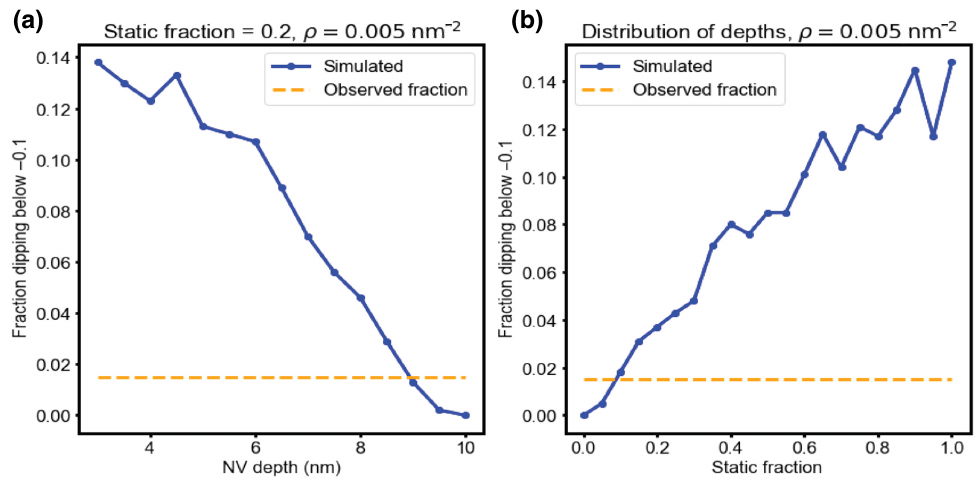
FIG. 22. Stationary surface spin fraction. (a) Simulation of the fraction of NV centers that exhibit strong coupling in DEER as a function of depth, if 20% of spins on the surface are placed randomly relative to the NV center and then do not hop. (b) Simulation of the fraction of NV centers that exhibit strong coupling in their DEER signal as a function of the fraction of spins that are stationary on the surface, given a density of σ = 0.005 nm − 2 , and depths drawn from the distribution of depths measured across all samples. Orange dashed line corresponds to the observed fraction of three strongly coupled DEER signals out of 191 NV